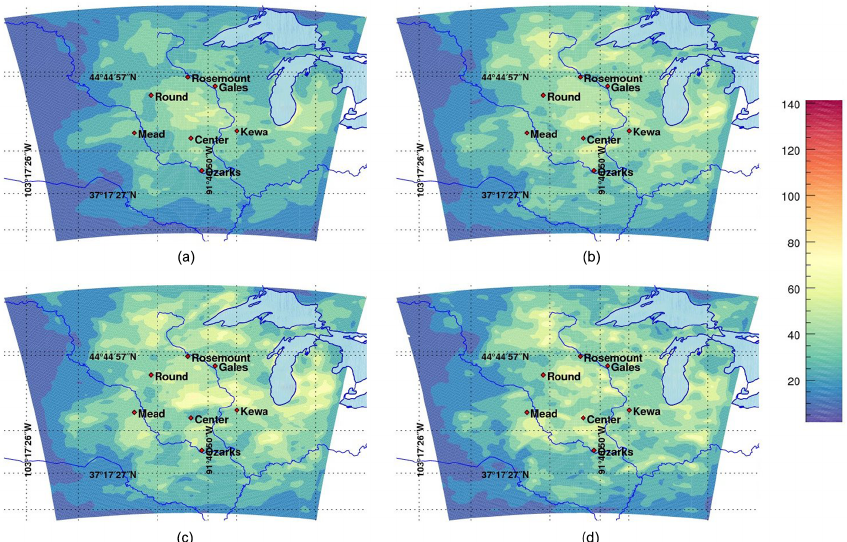
Figure 1. Variances of CO 2 in situ mole fractions (about 100ma.g.l.) (in ppm 2 ) using 25 members (a) , 10 members (b) , 8 members (c) and 5 members (d)